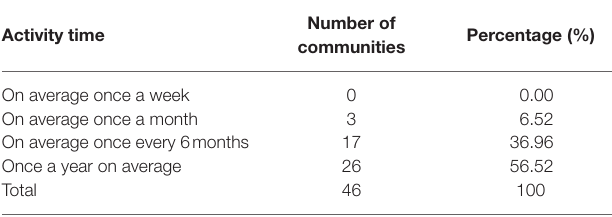
TABLE 3 | Psychological education knowledge development